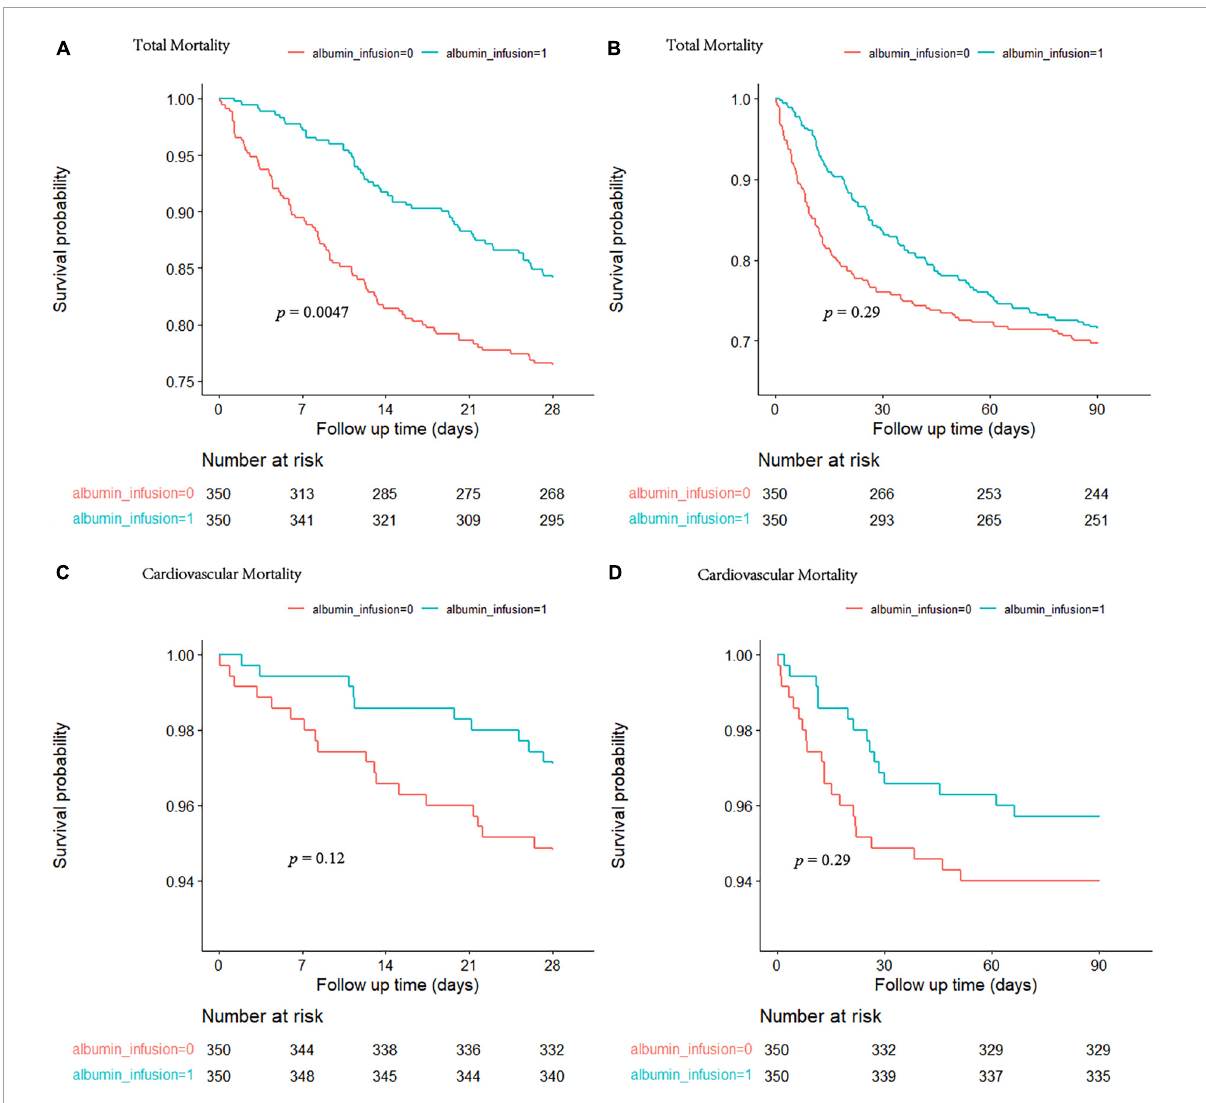
FIGURE1 The cumulative survival rate at 28 and 90 days for total mortality (A,B) and cardiovascular mortality (C,D) was calculated by the Kaplan-Meier survival analyses and the log-rank tests. The red curve represents the non-albumin infusion group. The green curve presents the albumin infusion group.